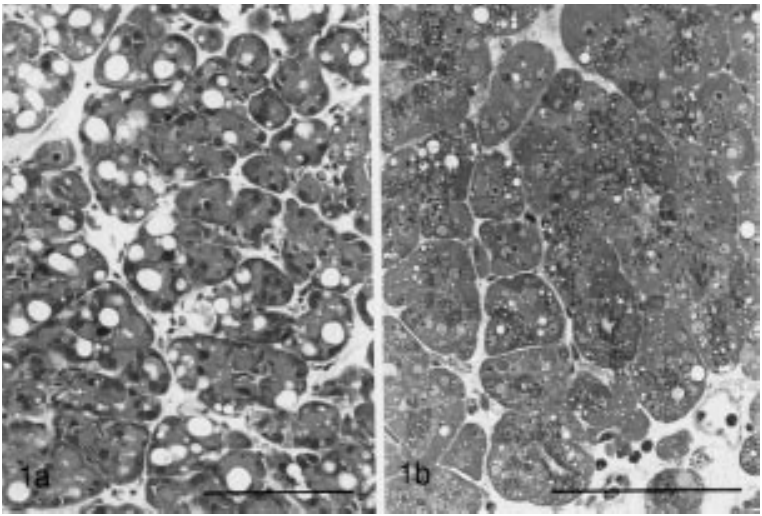
Fig. 1. (a) Semithin section of rat pancreatic exocrine tissue 8 hours after the induction of cerulein pancreatitis; ip application of cerulein (10 (cid:22) g/kg/h); toluidine blue staining; swiss cheese-like structure of pancreatic tissue, numerous big vacuoles are seen in the acinar cells, sometimes larger than the nucleus; some vacuoles reach a diameter of more than 20 (cid:22) m; corresponding serum (cid:11) -amylase activity of 69.6 mmol/l (cid:2) min) and a mean diameter of vacuoles of 15.7 (cid:6) 5.4 (cid:22) m in this special case (340 (cid:2) ). (b) WGA effect on the cerulein pancreatitis of rats; semithin section of rat pancreatic tissue 8 hours after simultaneous ip application of cerulein (10 (cid:22) g/kg/h) and WGA (125 (cid:22) g/kg/h); toluidin blue staining; numerous small vacuoles of about 0.5–4 (cid:22) m and some larger ones of about 10–15 (cid:22) m are visible in the acinar cells; in this animal a serum (cid:11) -amylase activity of 26.3 mmol/l (cid:2) min and a mean diameter of vacuoles of 6.2 (cid:6) 2.2 (cid:22) m were measured (410 (cid:2)